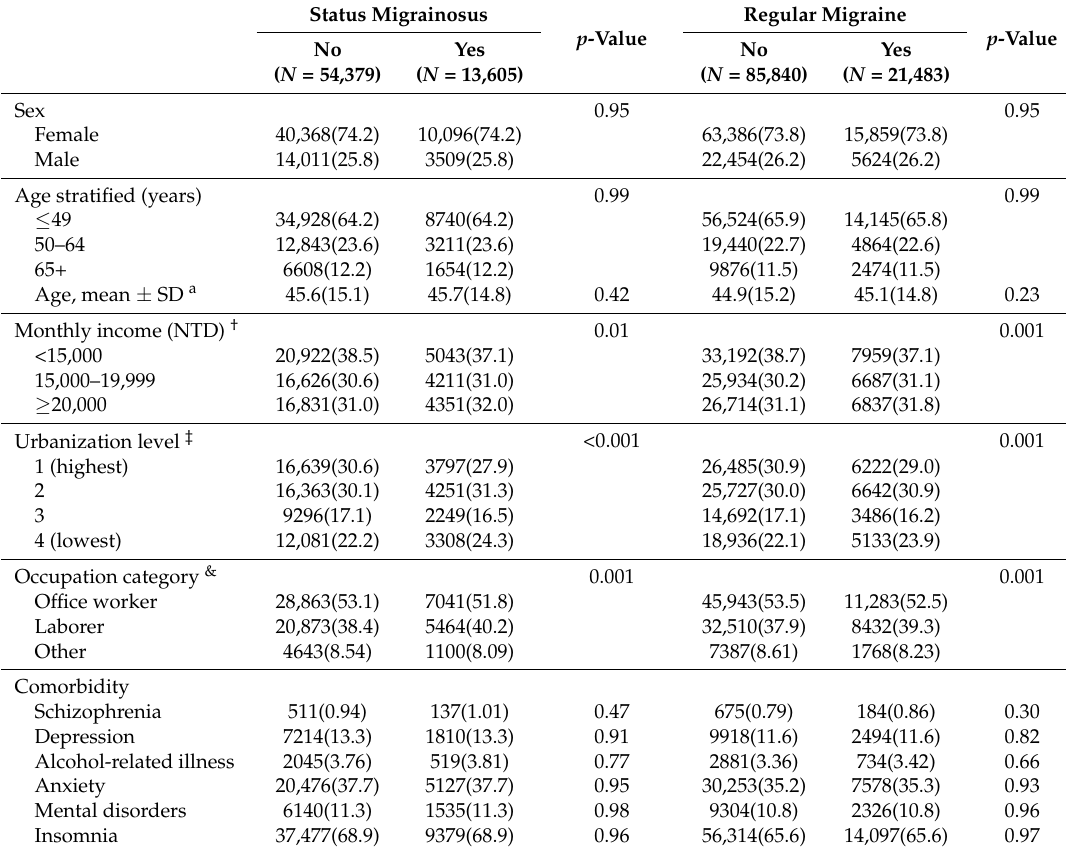
Table 1. Comparison of demographic characteristics and comorbidities in subjects with or without regular migraines and with or without status migrainosus.